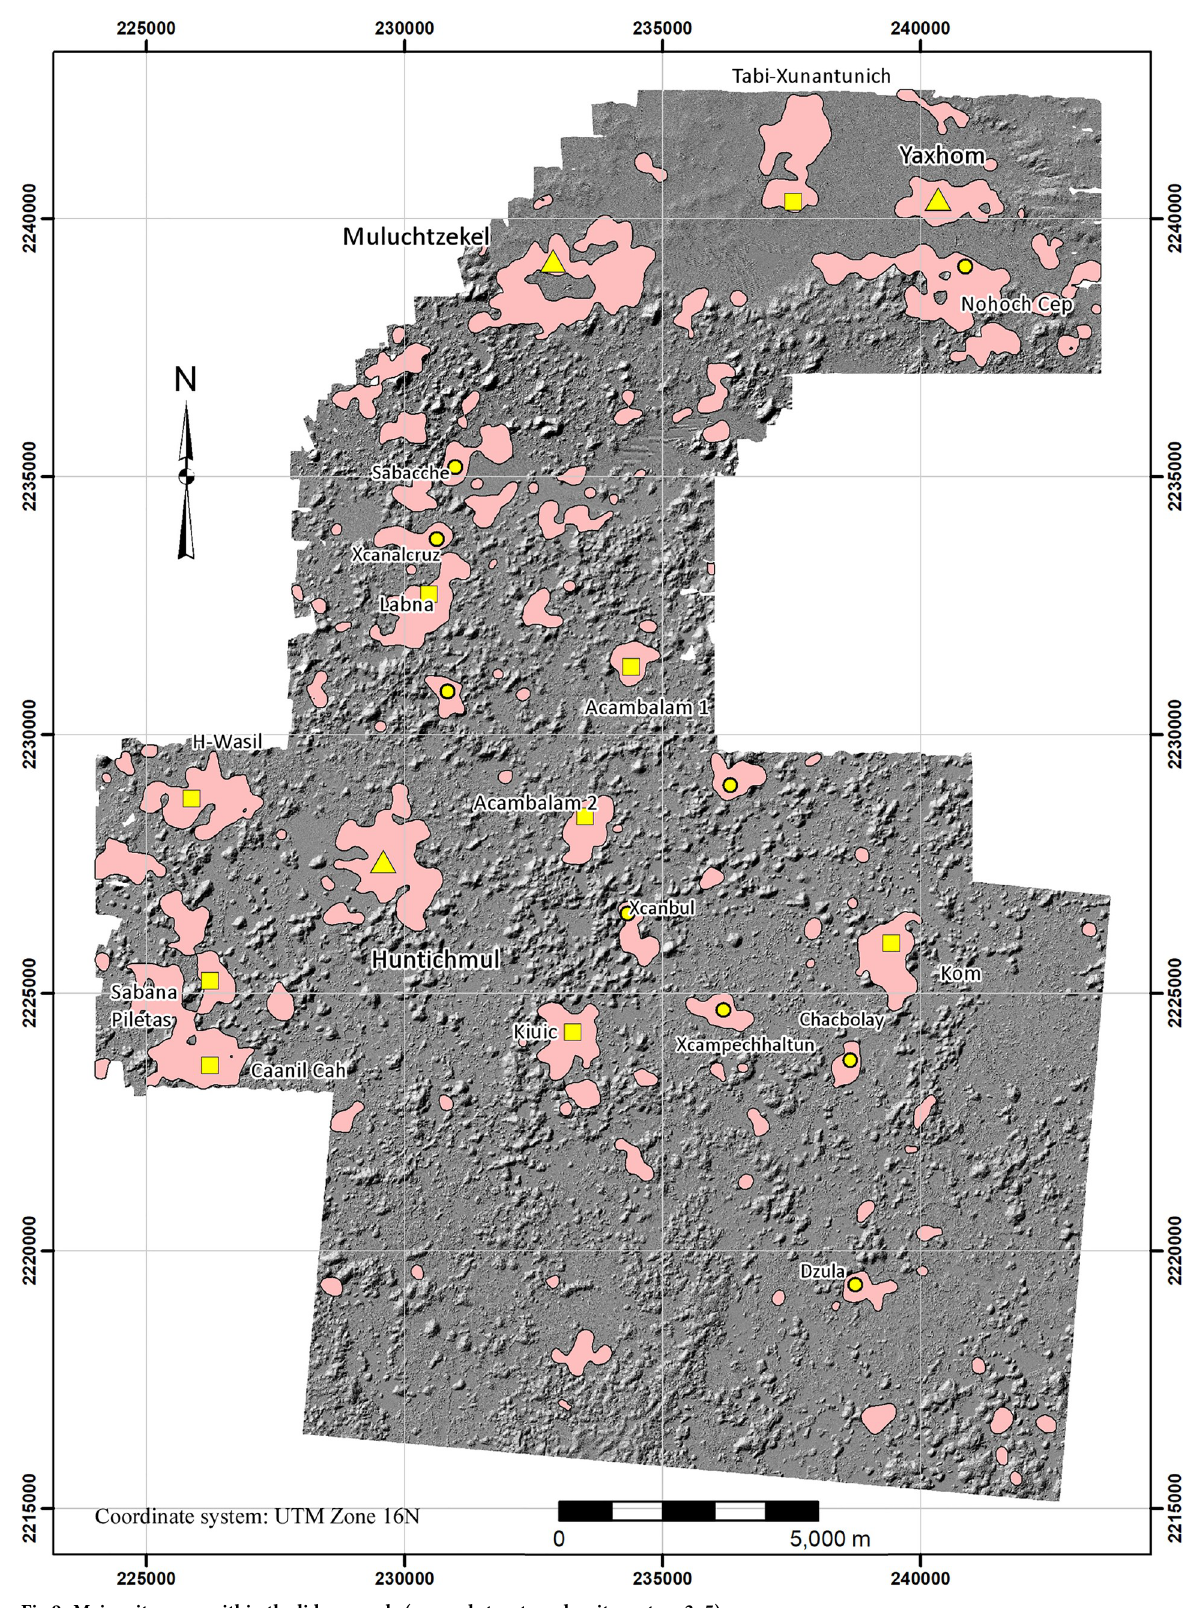
Fig 9. Major site cores within the lidar sample (merged structure density sectors 3–5).